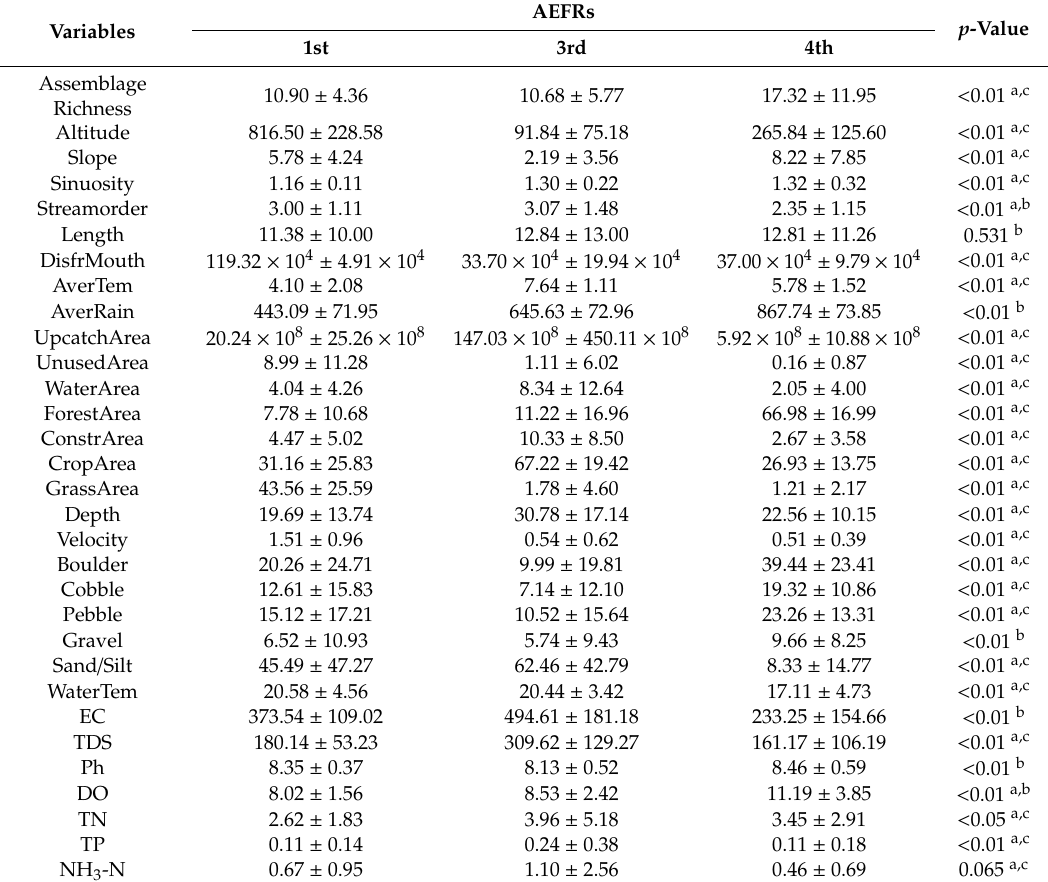
Table 2. Comparisons of assemblage richness and environmental variables (means ± SD) among di ff erent aquatic ecological function regions